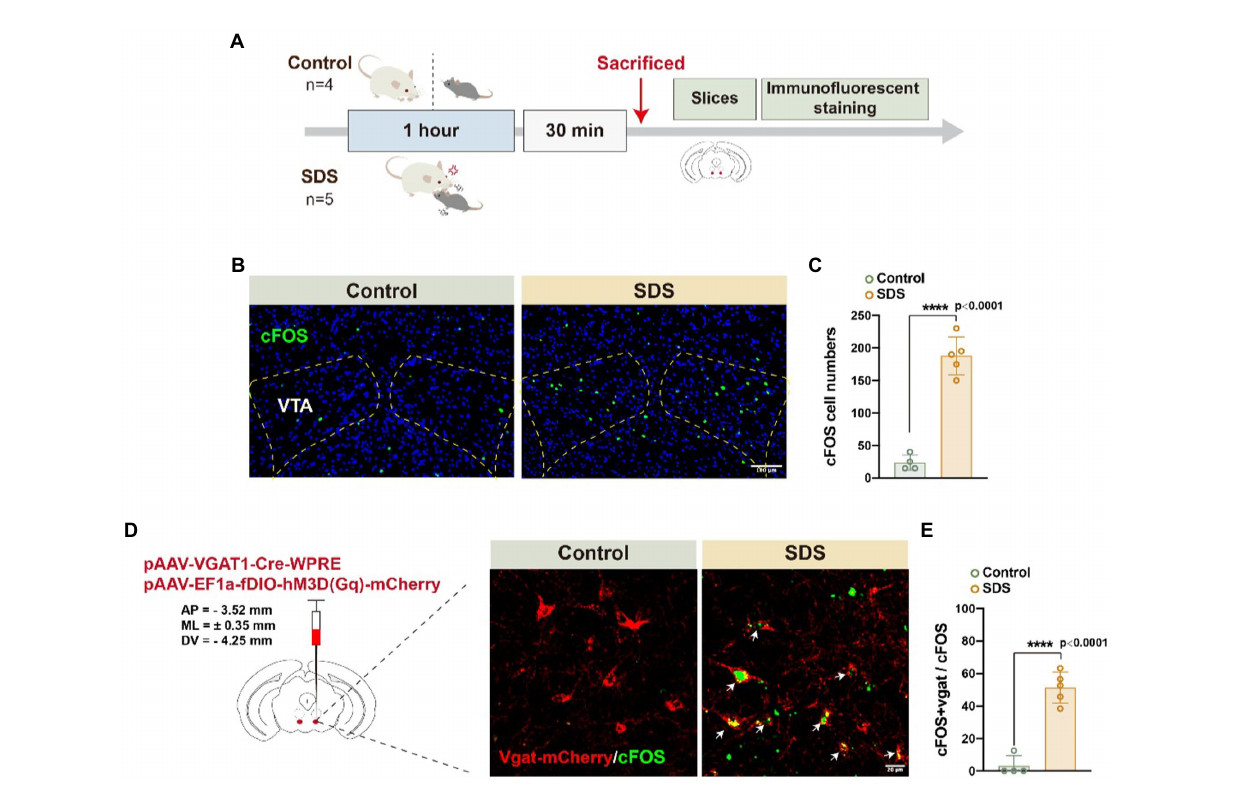
FIGURE 3 SDS activated VTA Vgat neurons in APP/PS1 mice. (A) Schematic diagram of the experimental procedure. The mice were sacrificed 30 min after the 1-h non-SDS (4 mice, control) or SDS (5 mice, SDS). (B) Representative images of cFOS expression in the bilateral VTA area in the non-SDS and SDS groups. Scale bar, 100 μ m. (C) Quantitative analysis of cFOS-positive cell numbers in (B) . (D) Representative images of Vgat-mCherry and cFOS in VTA area in non-SDS and SDS groups. Arrows point to the colocalization of Vgat and cFOS. Scale bar, 20 μ m. (E) Quantitative analysis of (D) in non-SDS and SDS groups. n = 4 for control and n = 5 for SDS, unpaired t